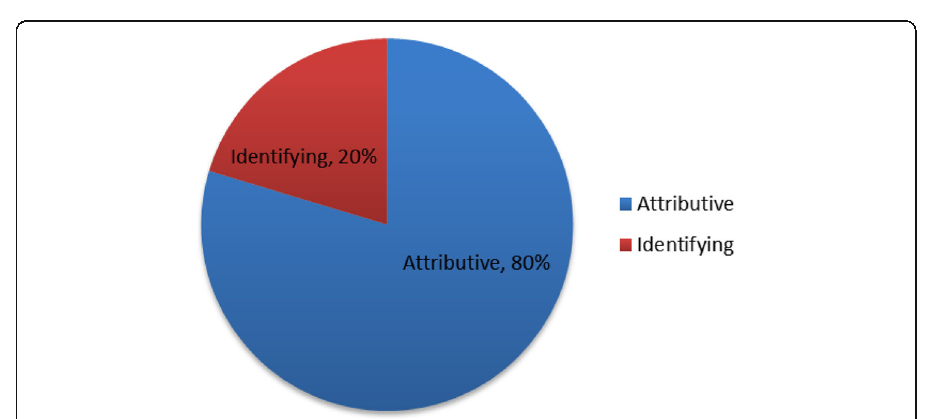
Fig. 5 Overall deployment of the two types of relational processes: attributive and